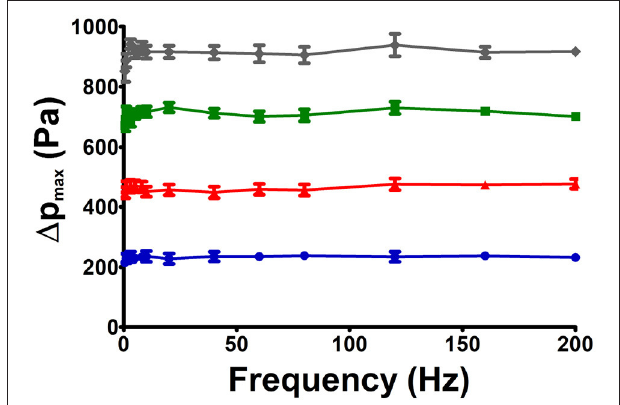
FIGURE 2 | Four different pressure drops were studied for each PEO solution in the range from 0.5 to 200 Hz. The experimental amplitude of pressure drop was held almost constant at 225, 450, 700, or 900 Pa by adjusting the voltage input to the piezoelectric actuator. Data shown corresponds to a PEO8 0.1% solution.